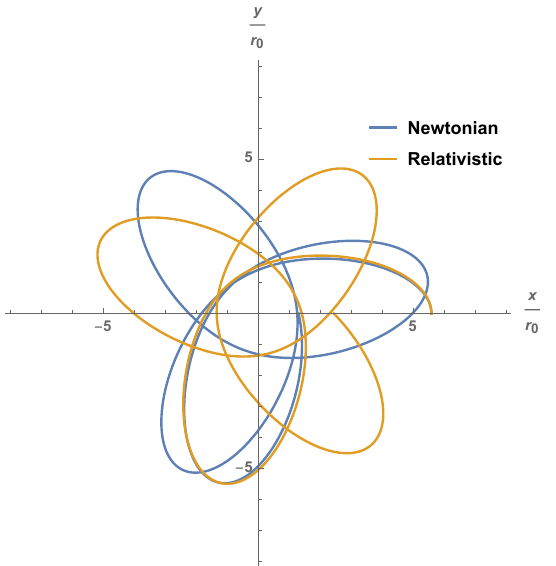
Figure 4 . Bounded orbits obtained via solving Eqns (5.30) (displayed as the blue line) and (5.29) (displayed as the orange line) with GM = : 2, L=r 0 = 1, and E = 1 : 1 V min